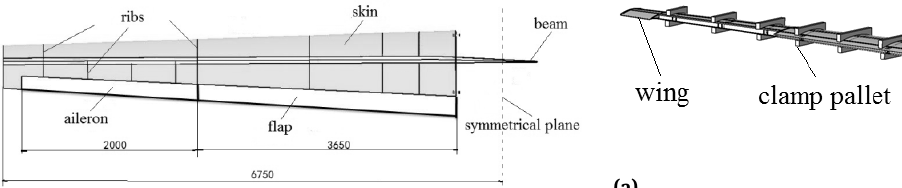
Figure 2: The wing structure (/mm)